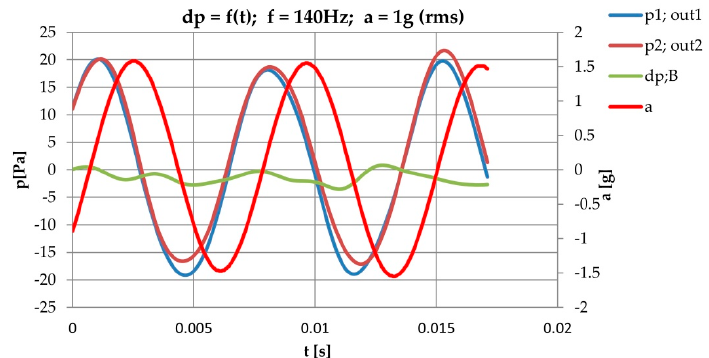
Figure 16. Response of the complex sensor to a harmonic signal with f = 140 Hz and a = 1g (Rms), p1- signal from the measuring sensor, p2-signal from the compensation sensor, and dp-difference between p1-p2, a-the input.